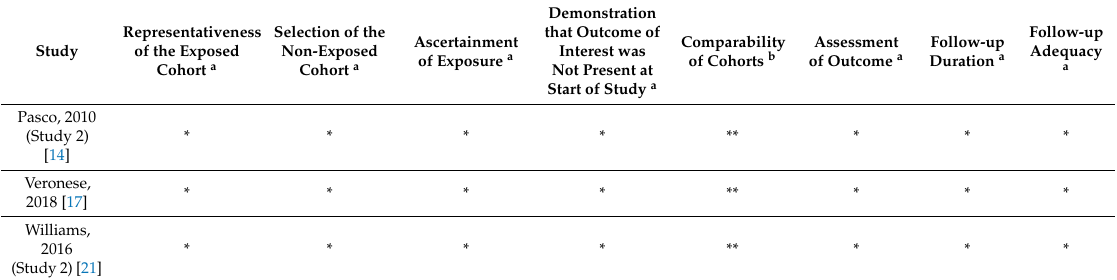
Table 2. The Newcastle–Ottawa Scale for assessing the quality of cohort studies